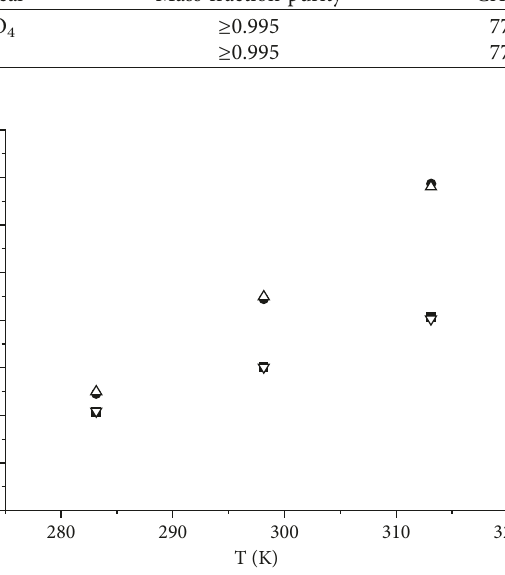
Figure 1: Solubility for KH 2 PO 4 or KNO 3 in pure water at 283.15, 298.15, and 313.15K. literary solubility of KH 2 PO 4 in water [18]; experimental solubility of KH 2 PO 4 in water; literary solubility of KNO 3 in water [10]; experimental solubility of KNO 3 in water.